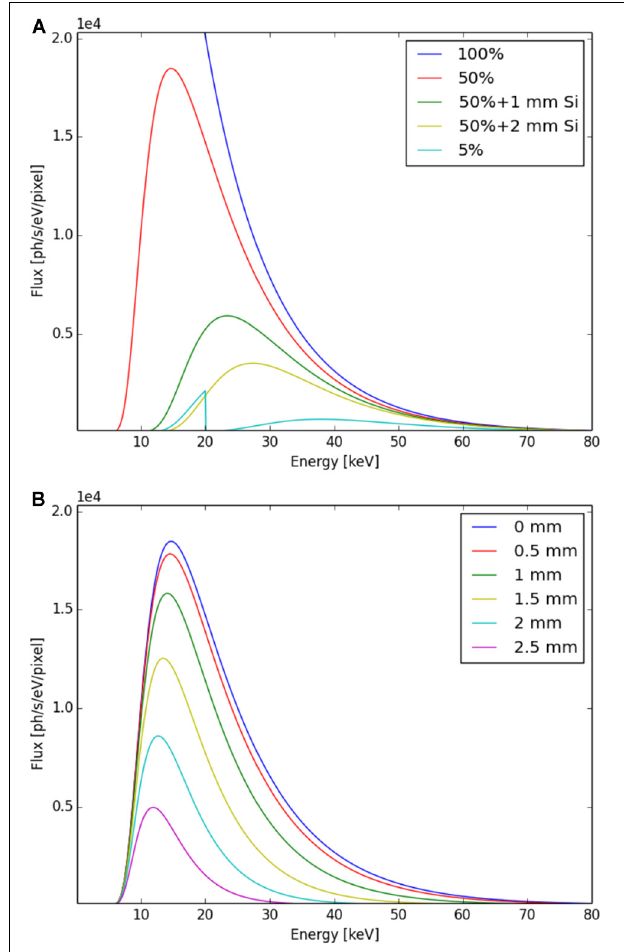
FIGURE 1 | Integrated flux over 2.75 × 2.75 µ m 2 (typical pixel area for dynamic experiments) at 25 m from the source delivered by the TOMCAT superbend (A) on-axis and filtered by different attenuators (50%: 5 mm Sigradur, 5%: 20 mm Sigradur and 75 µ m Mo), (B) off-axis at different vertical positions attenuated by the 50% filter. The flux is expressed per eV (instead of per 0.1% bandwidth) so that the absolute number of photons at a specific energy can be directly read from the